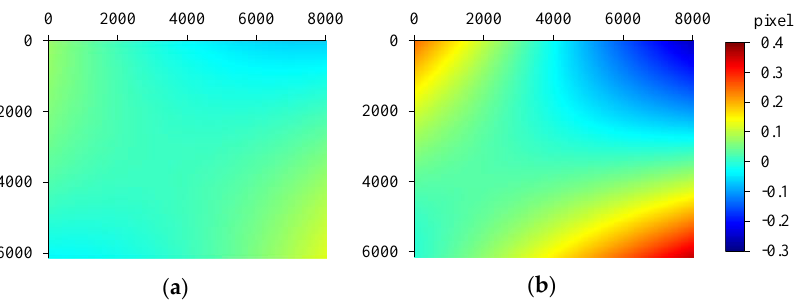
Figure 6. Distribution of the detected registration points by the proposed method.